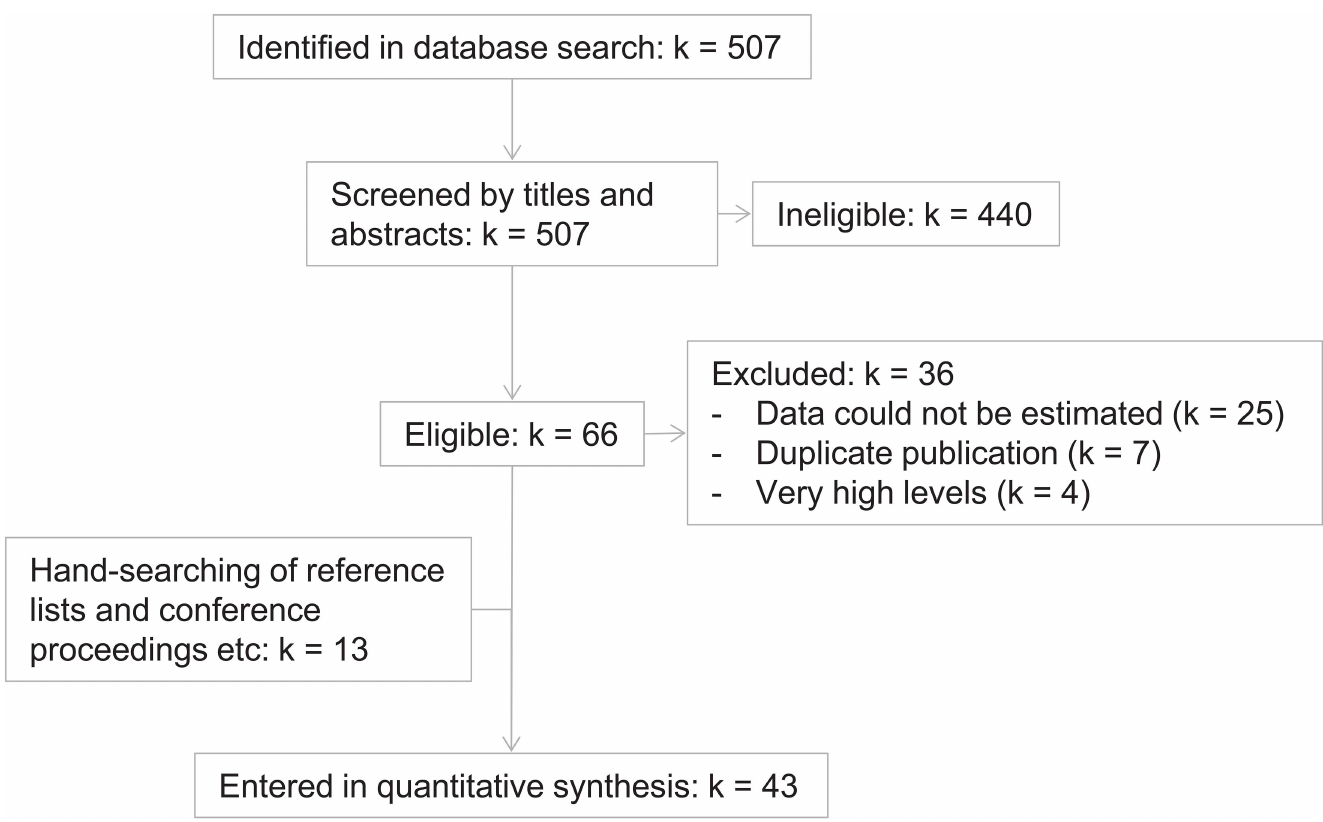
Fig 2. Data inclusion. Some of the 43 includedstudies containedmore than one dataset. The final numberof datasets was 56 (see Table